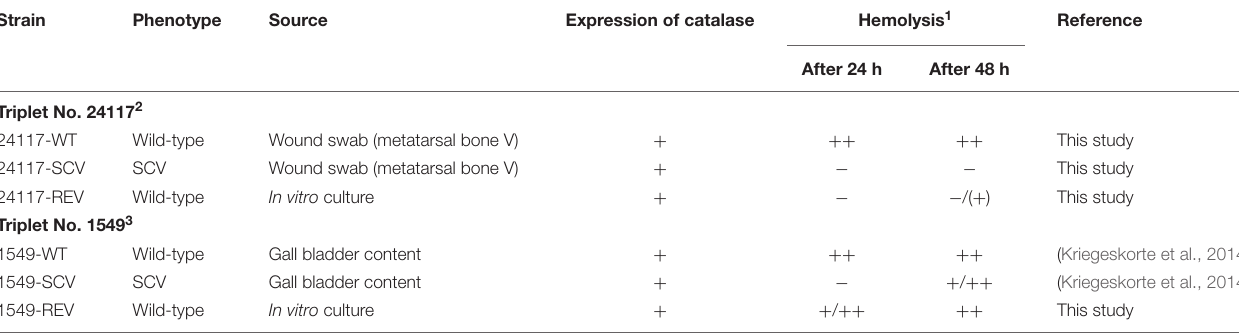
TABLE 1 | Characteristics of the strain triplets analyzed in this